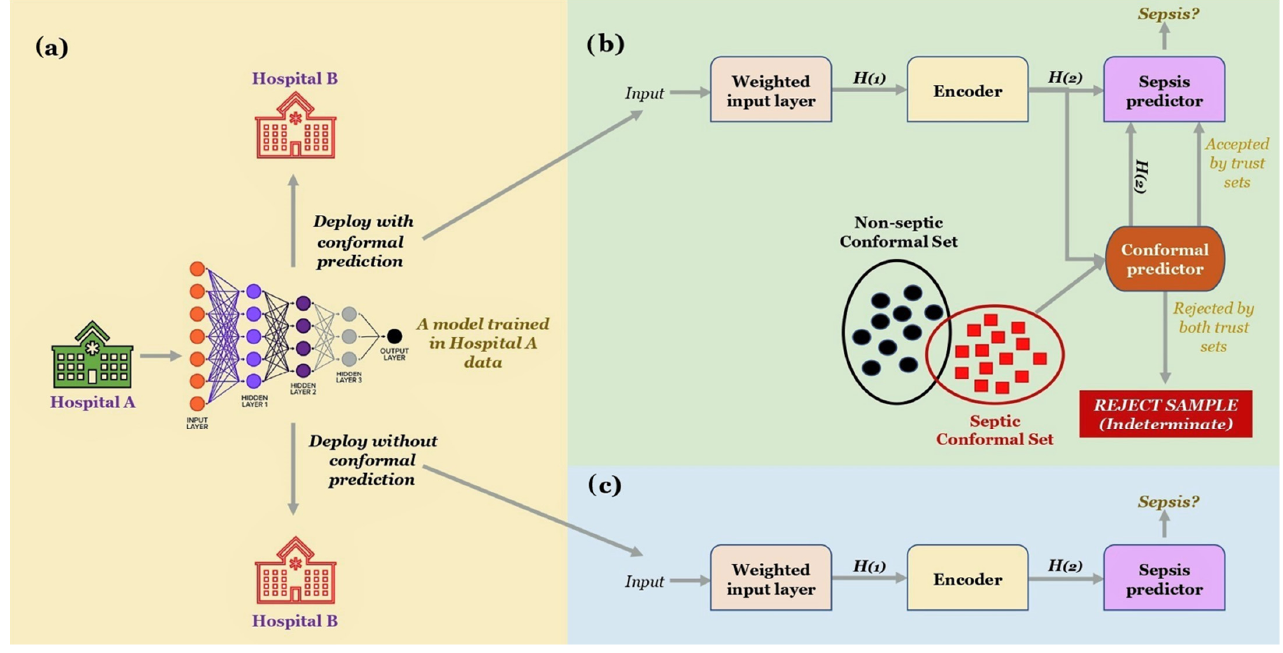
Figure 4. ML-based sepsis model: ( a ) during the evaluation phase of COMPOSER; ( b ) input data to obtain a risk factor for sepsis prediction; ( c ) a deployment scheme without the use of conformal prediction (adopted from Shashikumar et al. (2021)